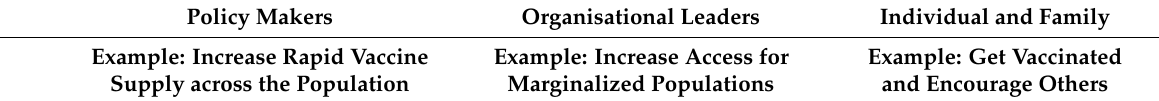
Table 1. The AACTT Framework Applied to Vaccine